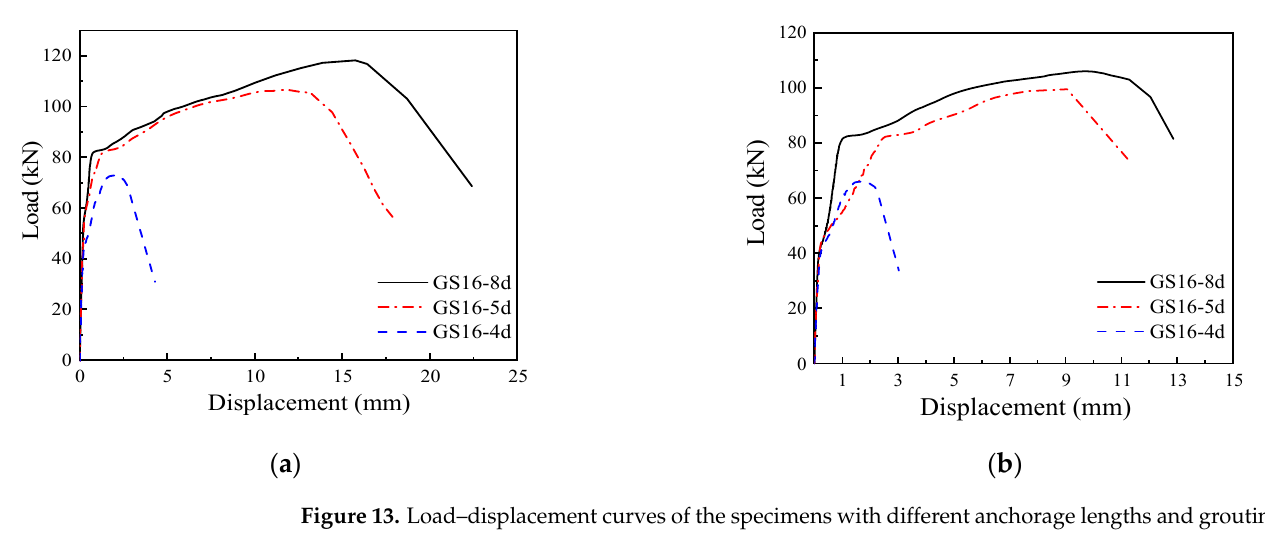
Figure 13. Load–displacement curves of the specimens with different anchorage lengths and grouting defects. ( a ) With 5% random defects. ( b ) With 10% random defects.